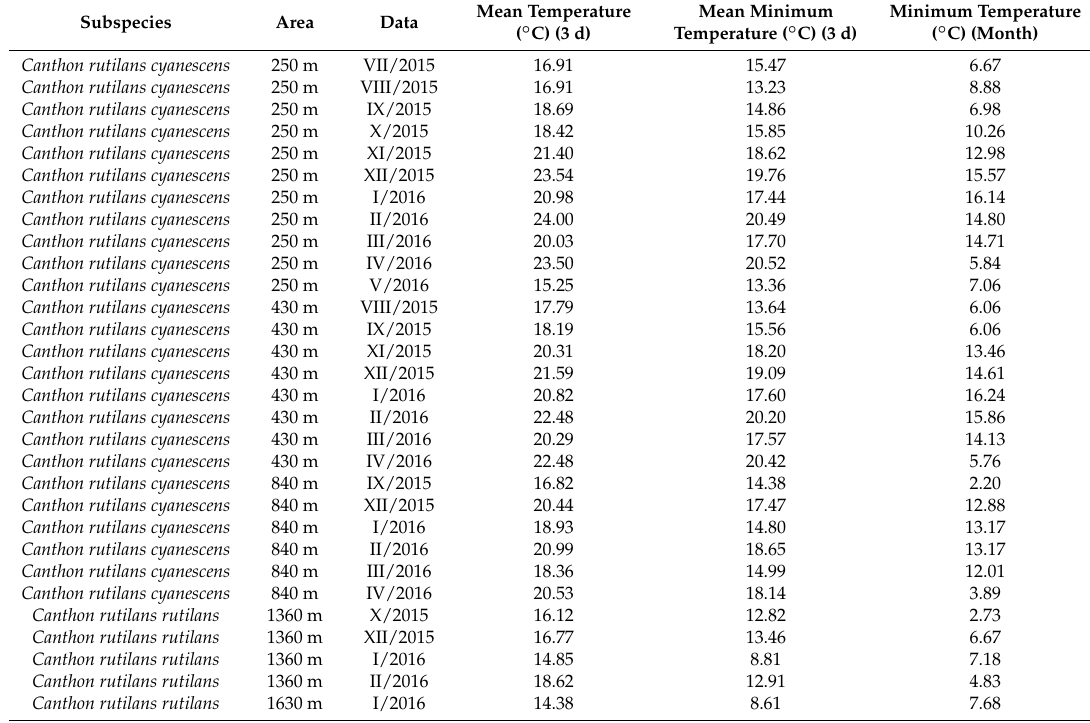
Figure 2. Temperature response curves for C. rutilans rutilans (in red) and C. rutilans cyanescens (in blue) considering the relative abundance of each sampling unit and its associated mean air temperature values (°C). Points are observed values and lines represent adjusted curves. Table 1. Presence of Canthon rutilans cyanescens and Canthon rutilans rutilans adults during the sampled year (June 2015 at June 2016). Mean temperature and mean minimum temperature (°C) during the three days of sampling and also minimum temperature during the month.